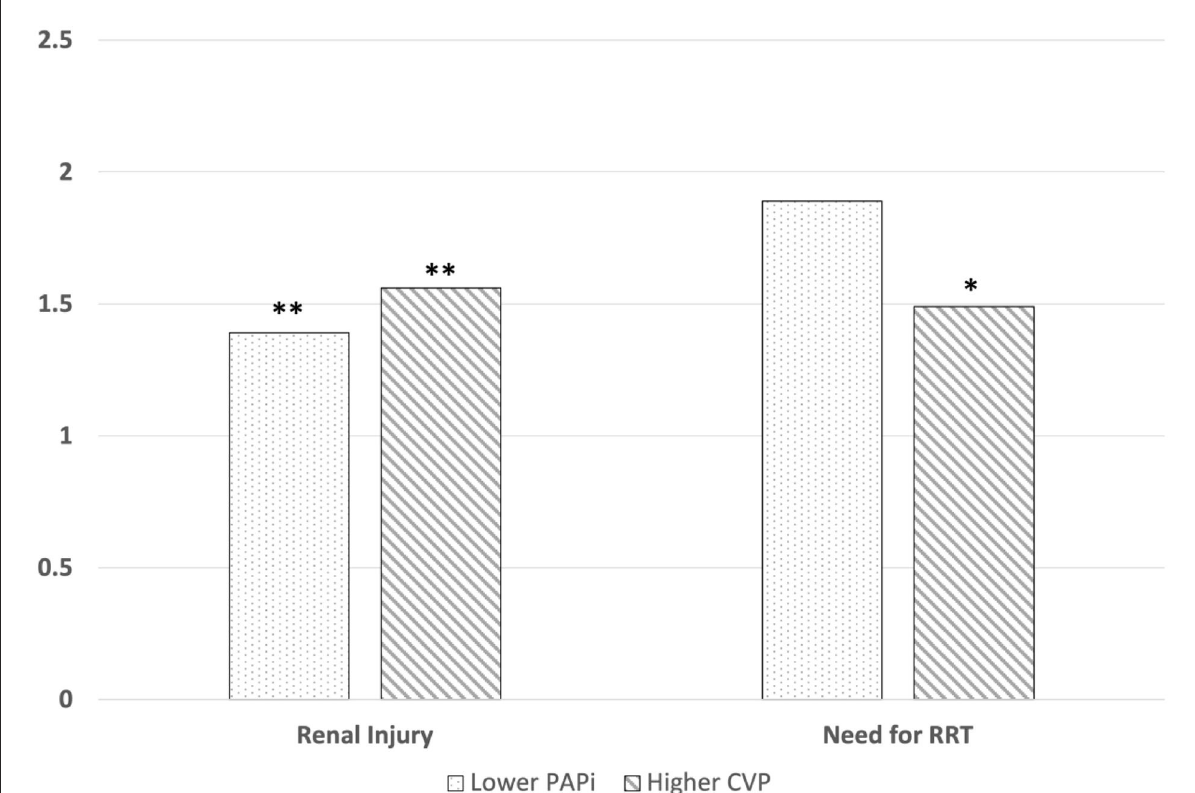
FIGURE2 Graphical representations for adjusted odds ratios for the association between postoperative PAPi and CVP and developing CS-AKI and requiring RRT The adjusted odds ratio for developing post-cardiac surgical acute kidney injury (AKI) in patients who developed AKI was 1.39 ( p < 0.01) for PAPi and 1.56 for CVP ( p < 0.01). The adjusted odds ratio for requiring RRT in 1.89 ( p = 0.14) for PAPi and 1.49 for CVP ( p = 0.02). ** = p < 0.01, * = p <